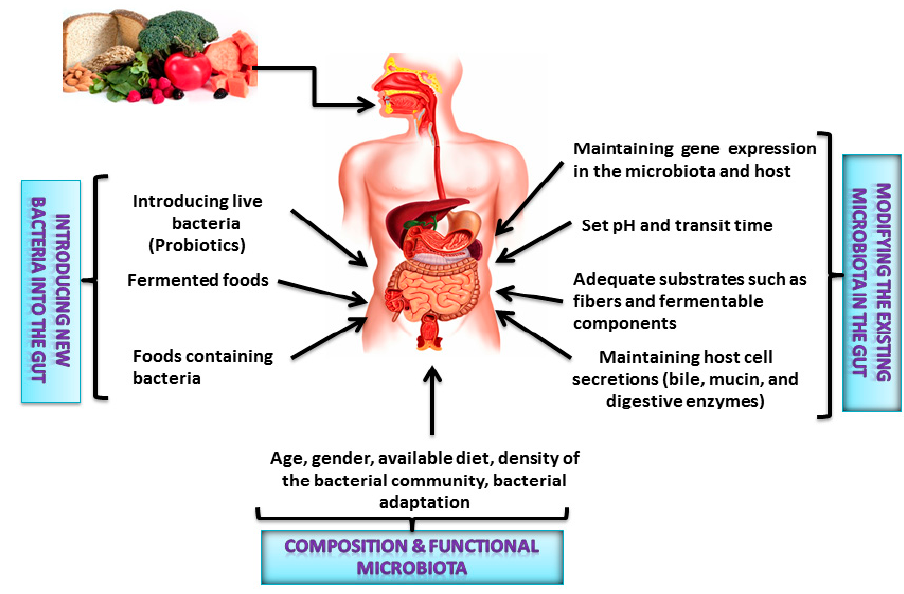
Figure 2. Dietary patterns, diet composition, and probiotics determine colonic microbiota composition and functions.